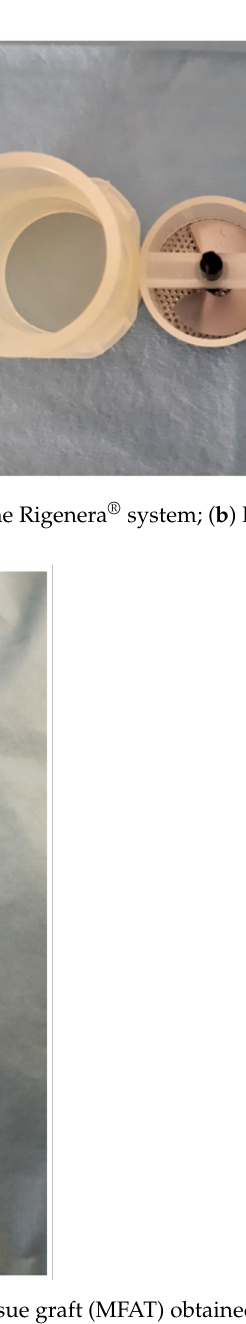
Figure 4. Microfragmented adipose tissue graft (MFAT) obtained from the dog, ready to